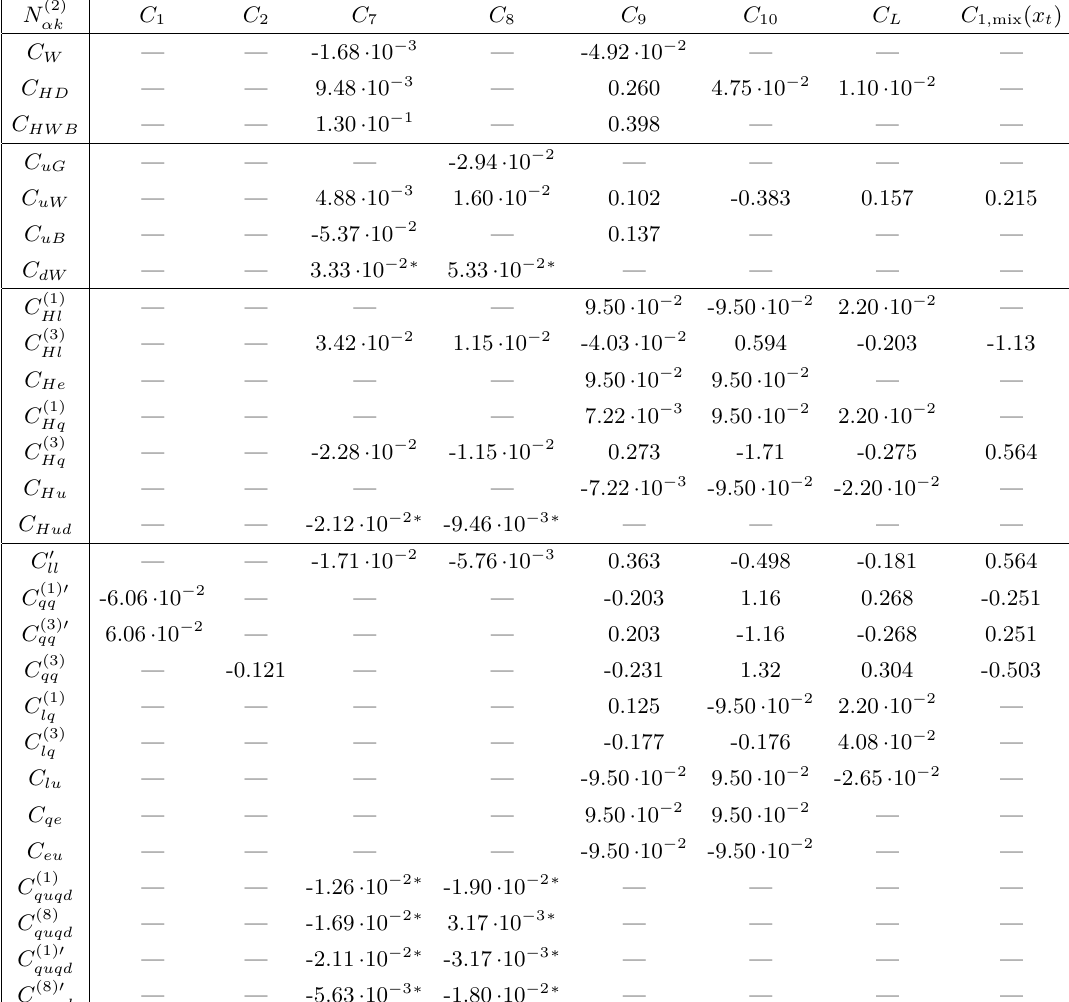
Table 4. Numerical values of the coefficients N (2) { m W , m Z , G F } input scheme. All results are quark-flavour universal ( C α ≡ C bs except for results indicated by an asterisk ( ∗ ), for which only C bd j α is meant ( d j = s, d